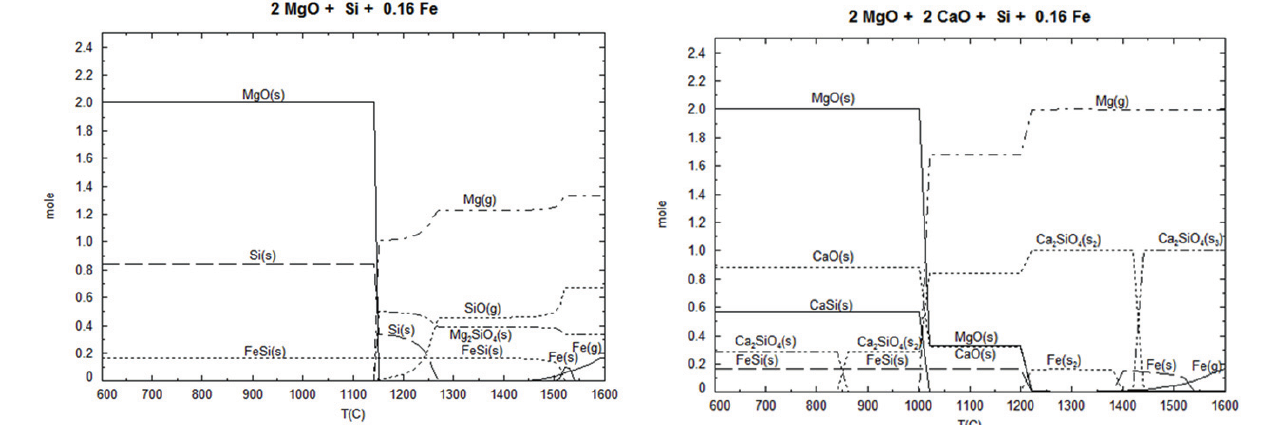
Figure 8. Stoichiometric FeSi amount to reduce dolime under 1 (cid:2) 10 2 Pa at different temperatures